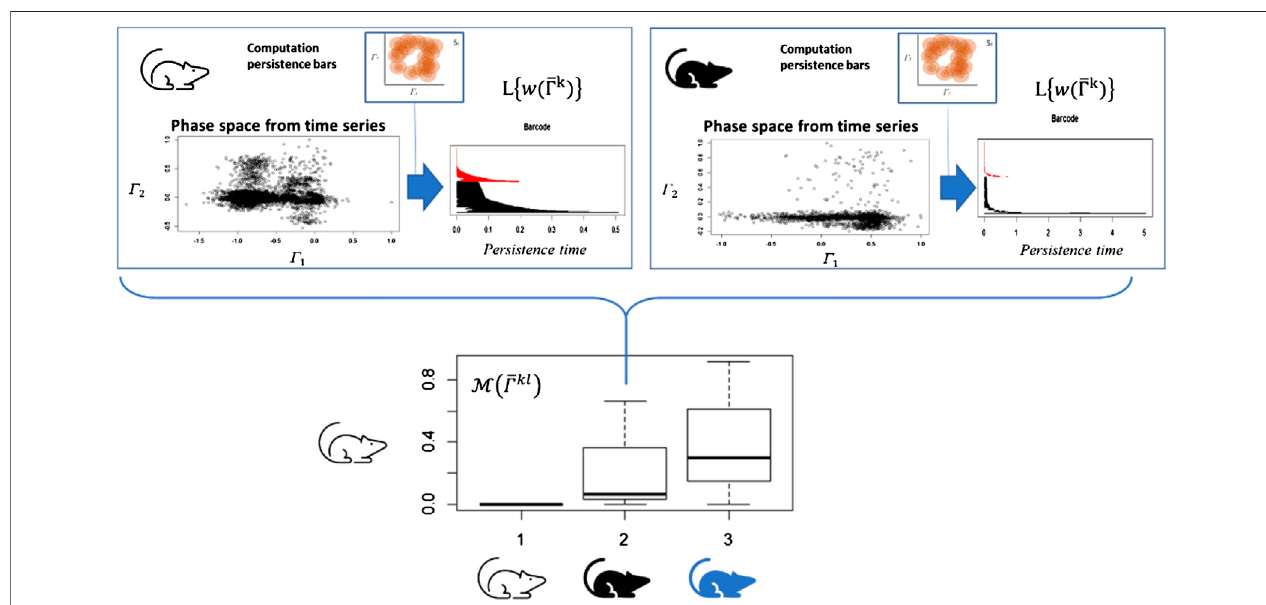
FIGURE 4 | Time series of each system or organism is analyzed as a point cloud in a phase space using topological invariance. Once the persistent diagrams are obtained, they are normalized respect to the highest value. The difference of the bar codes M ( Γ kl ) of the system k (for instance, the white mouse) respect to the other systems l is estimated according to Eq. 4 and represented as a box